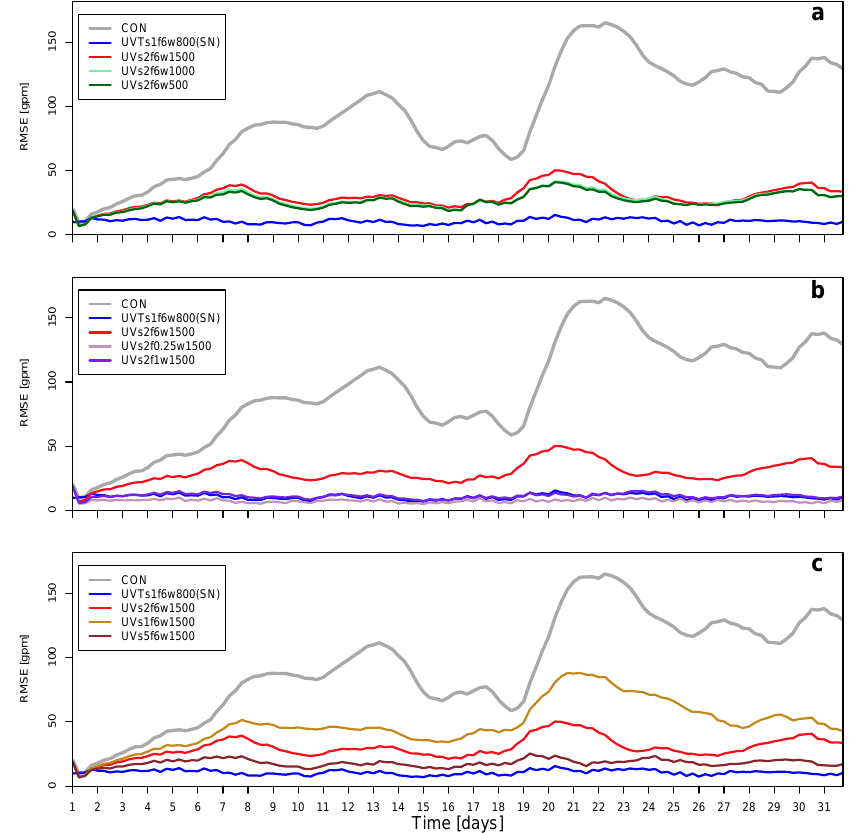
Fig. 2. RMSE of 500hPa geopotential for different tuning experiments with respect to ERA-Interim. Results are for December 1979, and are shown in steps of six hours. Three sets of experiments are showing sensitivity to (a) the shortest nudged wavelengths, (b) to the calling frequency of the nudging routine, and (c) to the strength of the nudging profile. Simulations are named as explained in the text. the coefficient multiplied by ten, (3) the nudging frequency indicated with an “f” followed by the update frequency in unit of hours, and finally (4) the shortest wavelength included in the nudging given in units of km after the letter “w”.